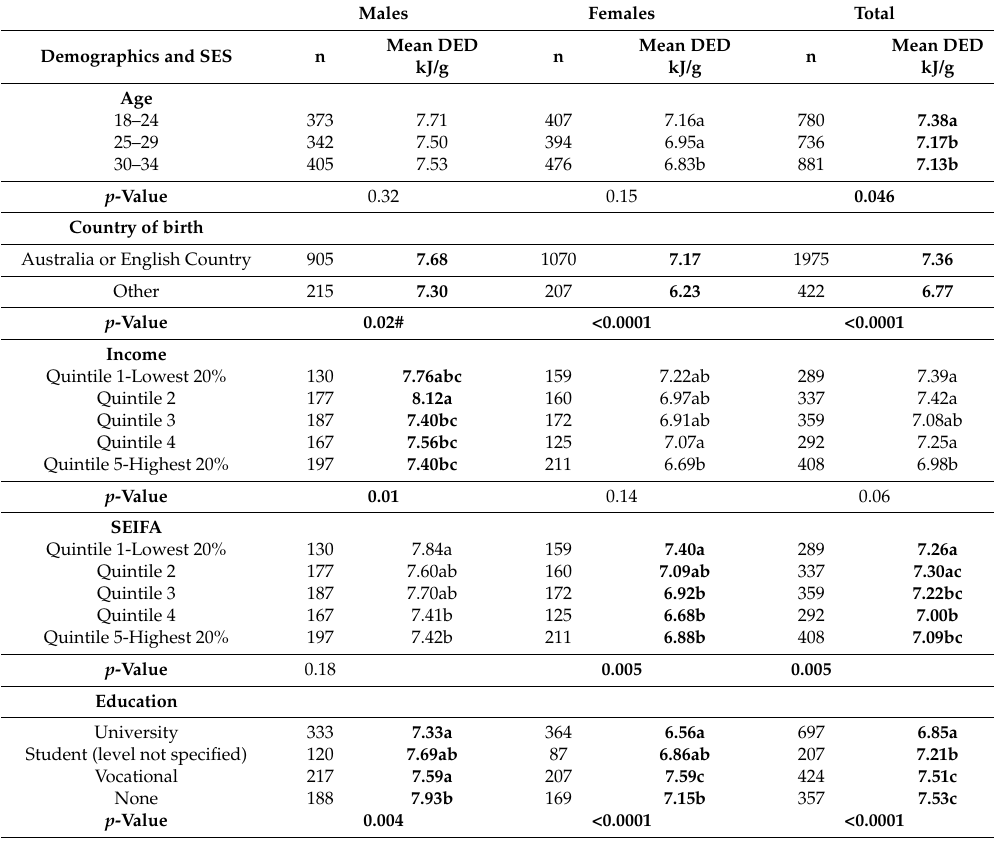
Table 3. Dietary energy-density (kJ/g) for subpopulations of young adults using dietary data from the first interview of the National Nutrition and Physical Activity